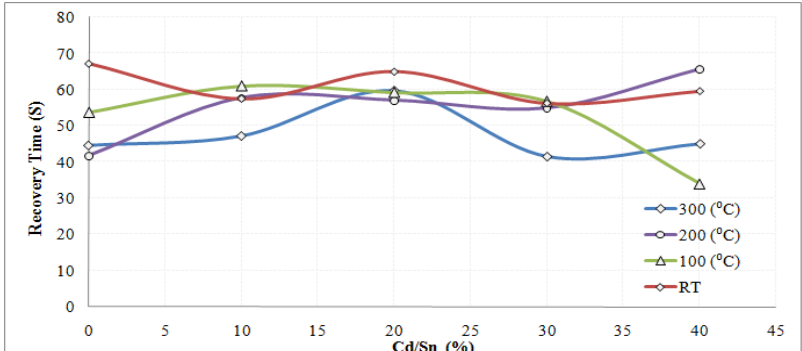
Fig. 7: The variation of recovery time as a function of time with different operating temperature of SnO : CdO thin films towards NO 2